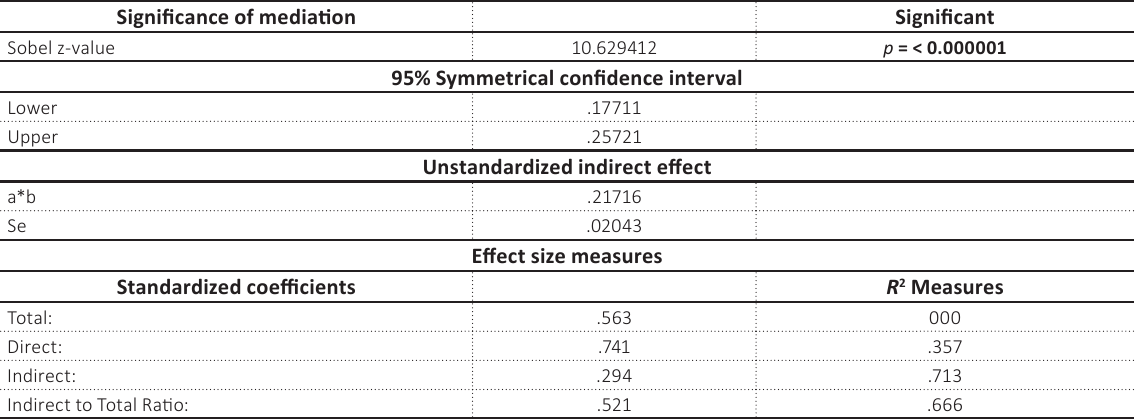
Table 7. Results of the Sobel test for the mediating effect Significance of